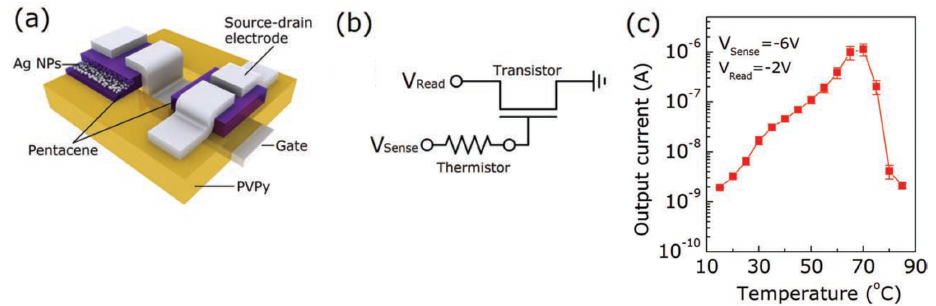
Figure 7. ( a ) The schematic diagram of the transistor–thermistor temperature sensor; ( b ) The circuit of temperature sensor; ( c ) I DS response to temperature of the transistor-thermistor device. Reproduced with permission from [42] Wiley-VCH,